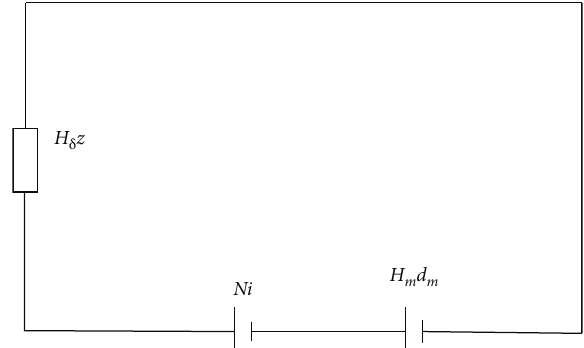
Figure 3: Simplified magnetic circuit of electromagnetic-perma- nent magnet mixed suspension. z is the suspension gap, d m is the thickness of the permanent magnet, N is the number of turns of the magnet coil, i is the current passing through the electromagnetic is the magnetic field strength of the air gap, and H m is the coil, H δ magnetic field strength of the permanent